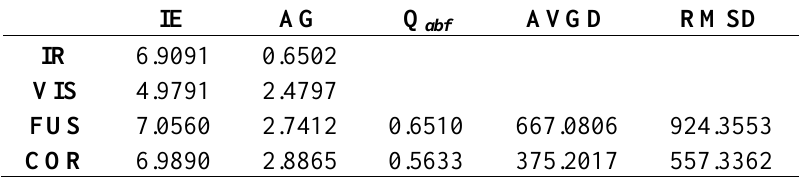
Table 1. Quantitative analysis of IR and VIS image fusion and physical correction. The satellite data were collected on 1300 LST 26 July 2006. IR: infrared image. VIS: visible image. FUS: fused image using multiwavelet. COR: corrected image. IE